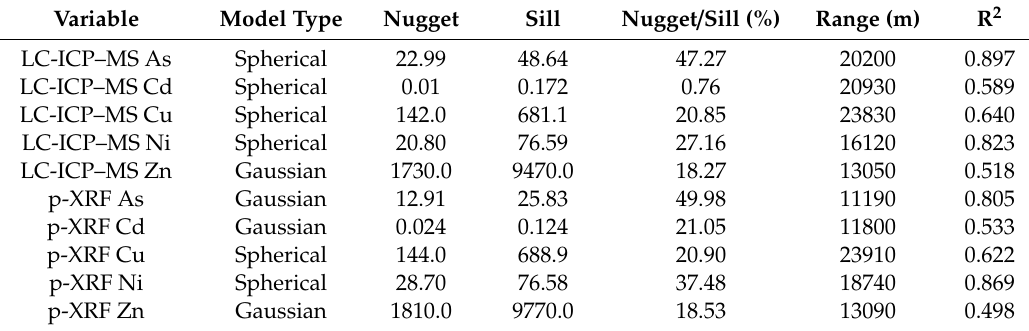
Figure 3. Semivariogram of PTEs content measured by LC-ICP-MS (left column) and p-XRF (right column).